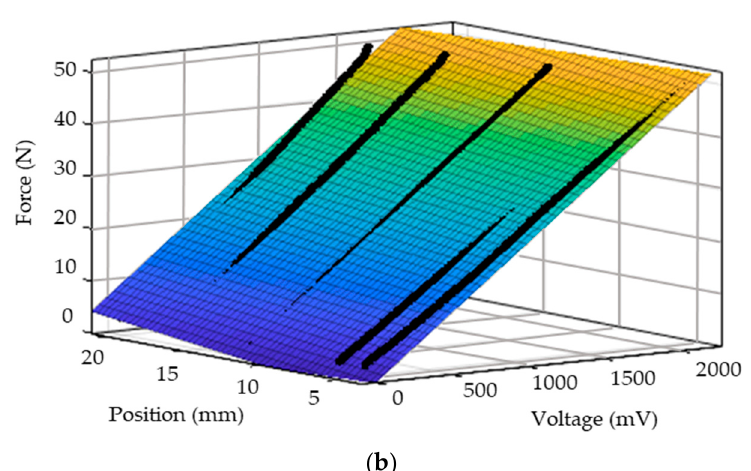
Figure 6: ( a ) Force–voltage curves at five contact points; and ( b ) estimated plane of force as a function of voltage and position.